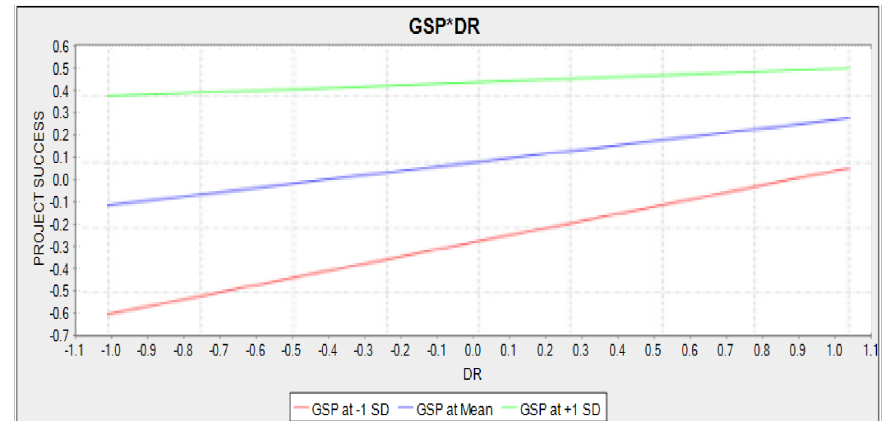
Figure 4. Moderating effect of government support on the effect of design risk factors on project